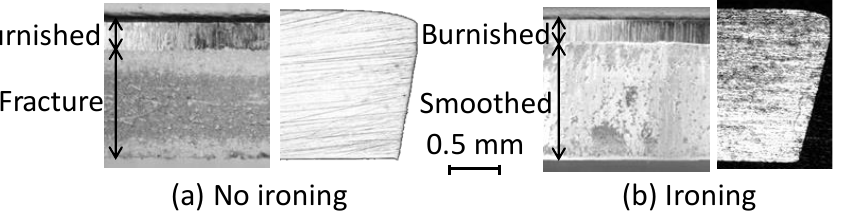
Figure 6. Surfaces and cross-sections of edges ( a ) without and ( b ) with ironing for punched 980 ultra- high strength steel sheet of 20% clearance ratio [37].